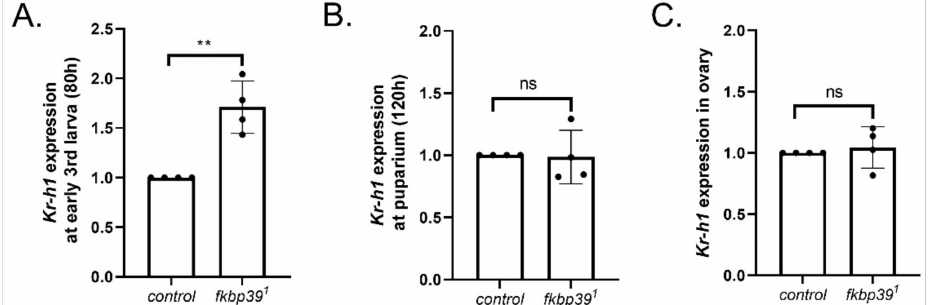
Figure 6. FKBP39 controls Kr-h1 expression. ( A ) Fold change of the kr-h1 mRNA at early 3rd instar larval stage in fkbp39 mutant. ( B ) Fold change of the kr-h1 mRNA at the puparium in fkbp39 mutant. ( C ) Fold change of the kr-h1 mRNA in fkbp39 mutant ovary. Actin is used for normalization. Error bars represent the SD of four independent experiments. ** p < 0.01; ns, not